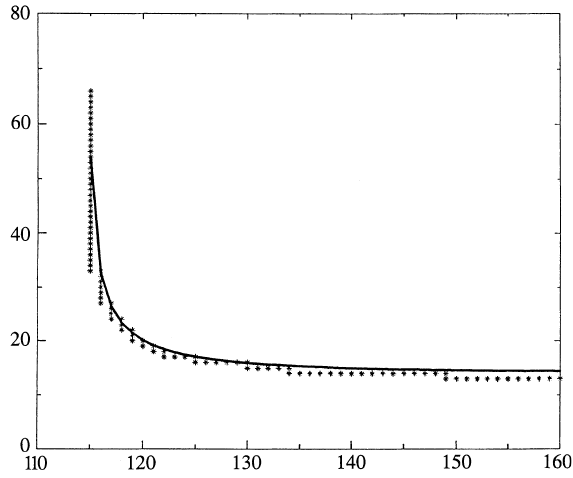
Fig. 8. Result of the control simulation for aircraft wake vortices. Comparison of the right-hand vortex trajectory simulated by the model (stars) with the analytical solution [ continuous line from Eq.(78)]. The coordinate lines are labelled in m, and the pair or vortices is initially released at the height